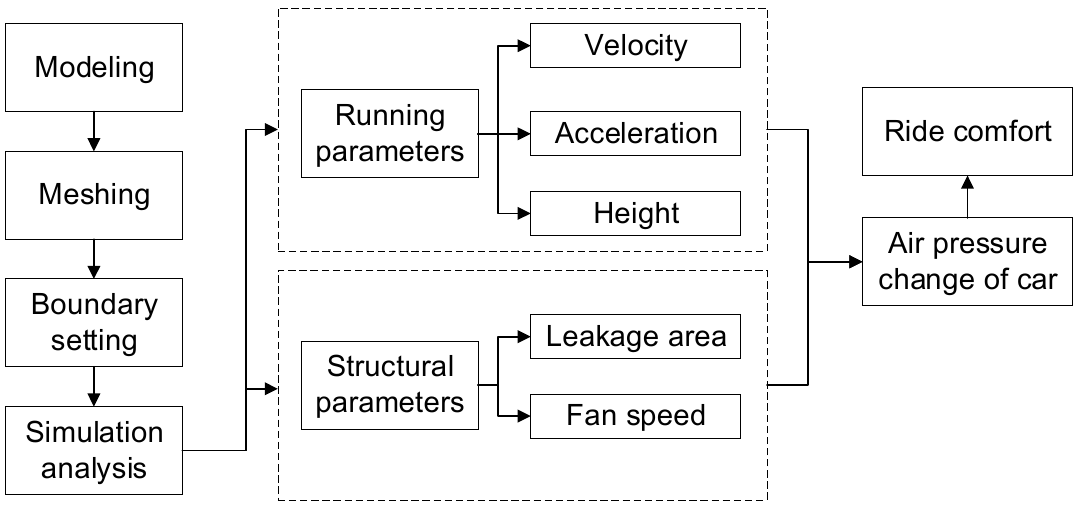
Figure 11. Simulation analysis process of the air pressure change inside and outside the car.